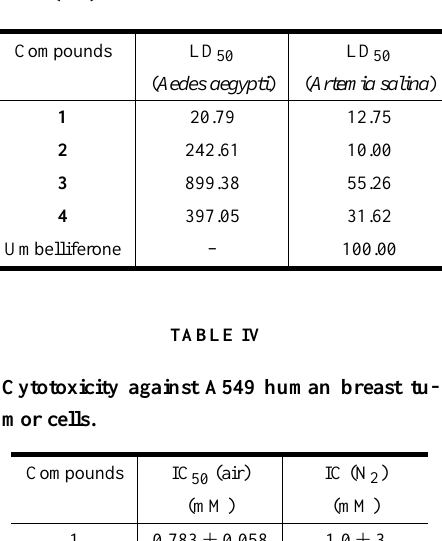
Activity against Aedes aegypti and Artemia salina of lapachol (1) and the enamine deriva- tives (2-4).